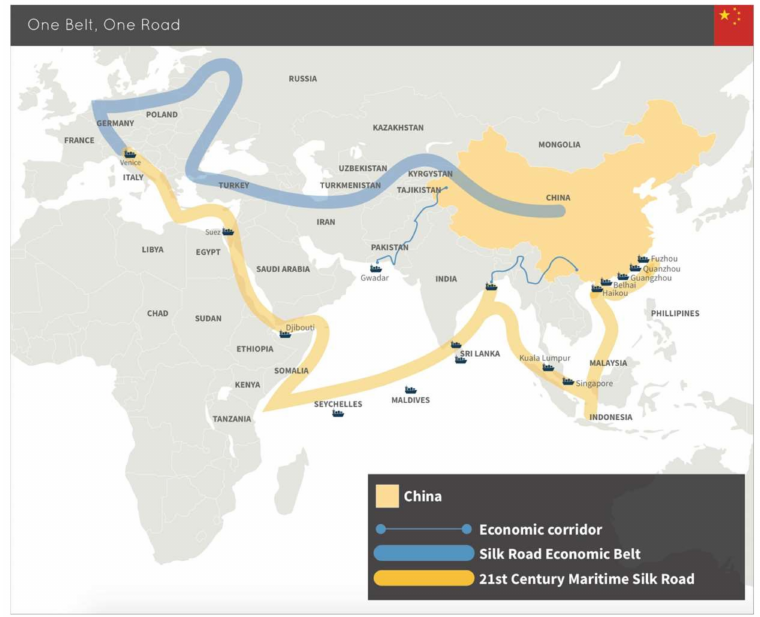
Figure 11. Geographic scope China’s Belt and Road Initiative. Map by Peter Cai [141], reproduced with permission of the Lowy Institute, <https://www.lowyinstitute.org/publications/understanding-